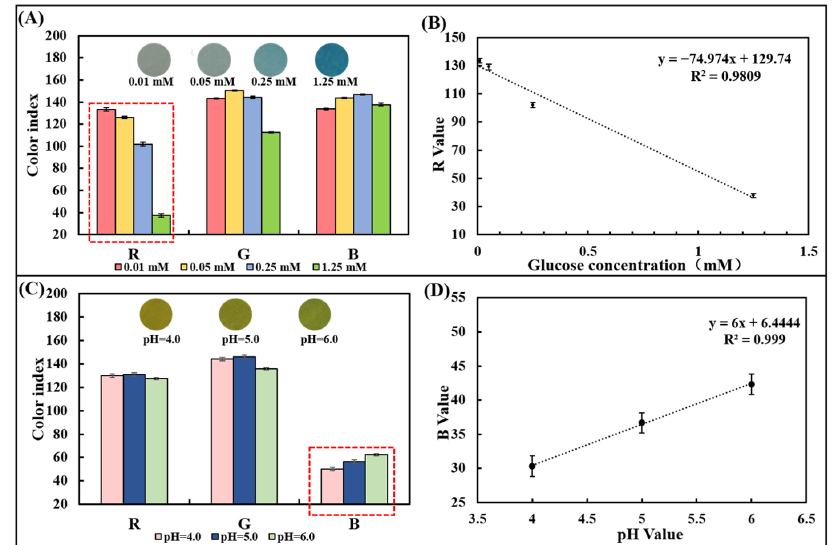
Figure 3. Optical color model selection for glucose concentration and pH detection using pure sample out of the chip. ( A ) RGB values of the paper-based glucose sensor after reaction with pure samples containing glucose with different concentrations. ( B ) Linear plot of the R-value obtained from the paper-based sensor versus the corresponding glucose concentration. ( C ) RGB values of the paper-based pH sensor after reaction with pure samples with different pH values. ( D ) The plot of the linear relationship between the R-value obtained from the paper-based sensor and the corresponding pH value.